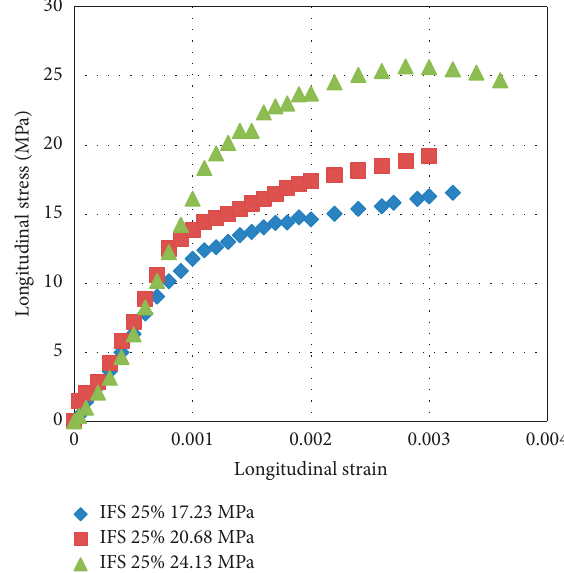
Figure 19: Longitudinal stress-strain diagram RAC with 25%